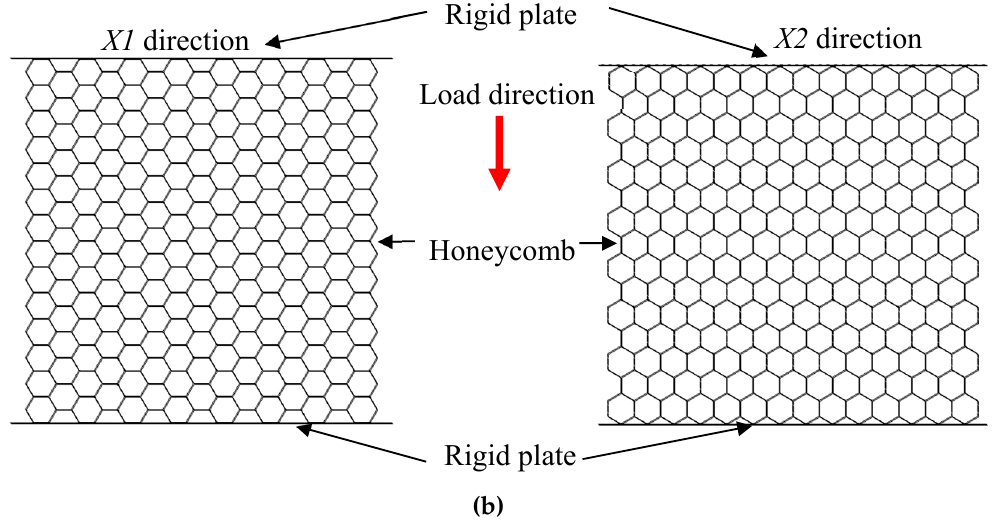
Figure 3. Equivalent finite element models, (a) honeycomb-rigid plate (H-RP) in the X1 and X2 direction; (b) rigid plate-honeycomb-rigid plate (RP-H-RP) in the X1 and X2 direction.